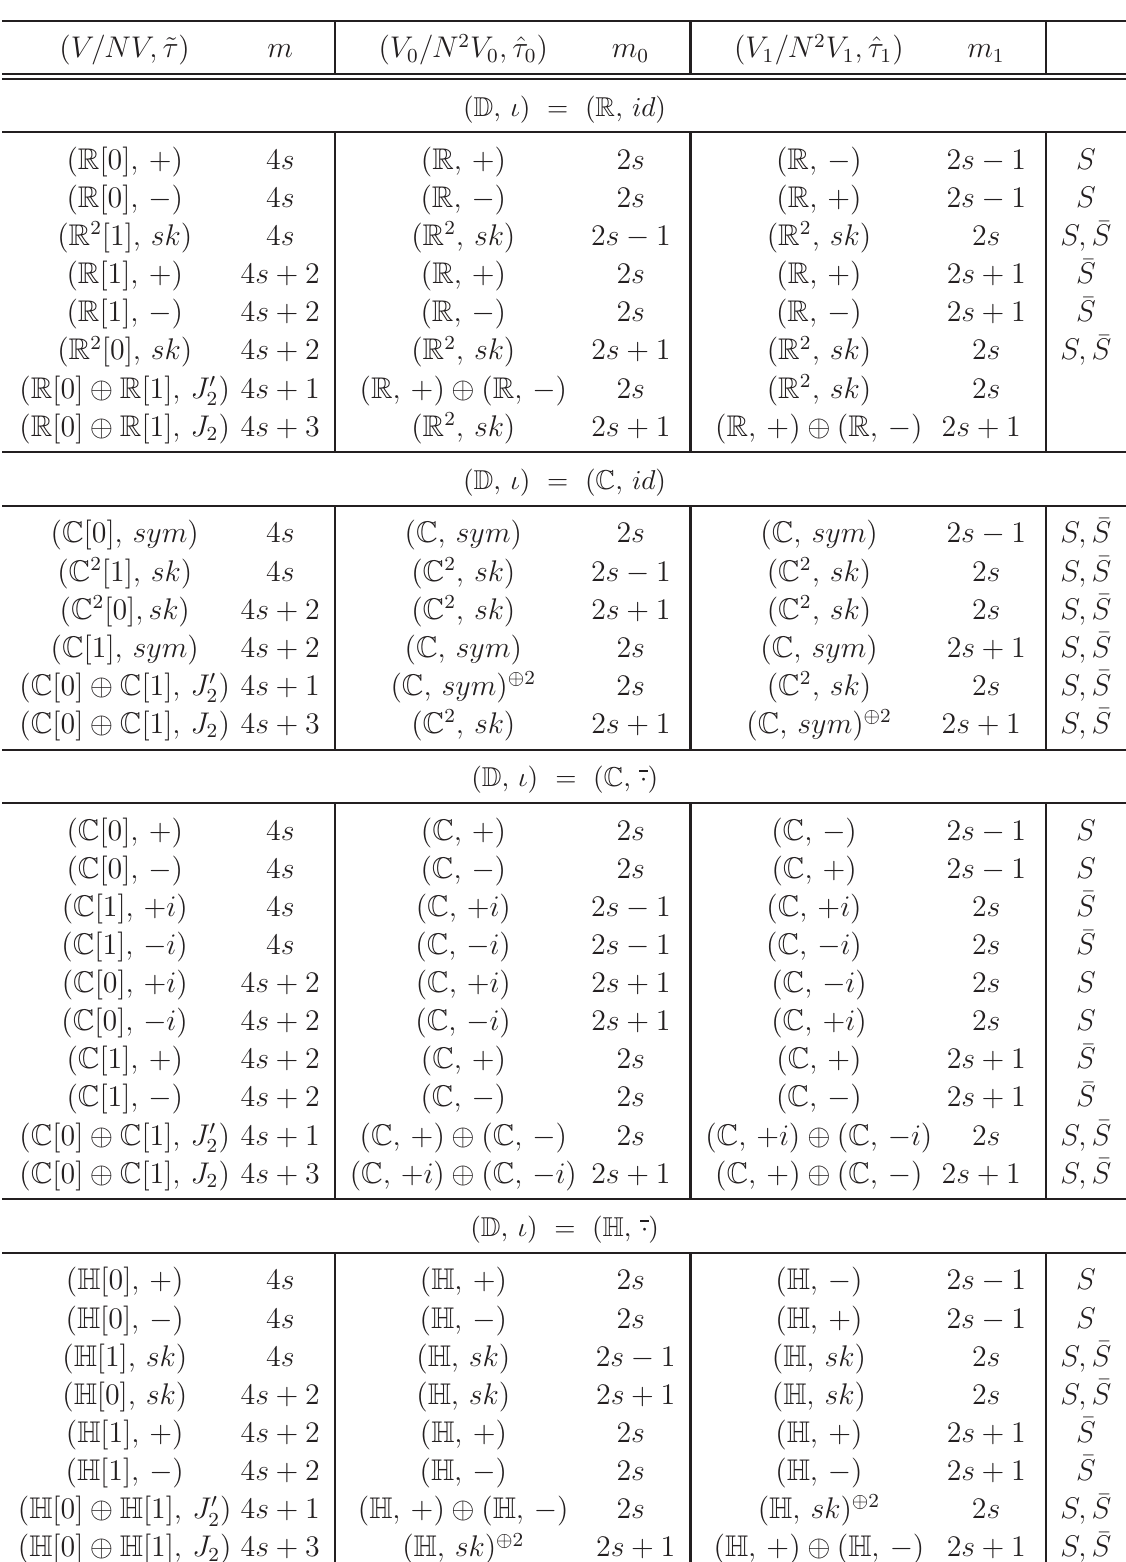
Table 3 Moment maps on indecomposable orbits in W